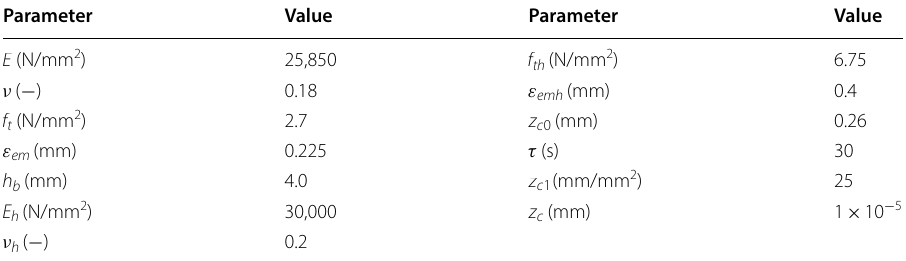
Table 3 Model parameters L‑shaped specimen test Parameter Value